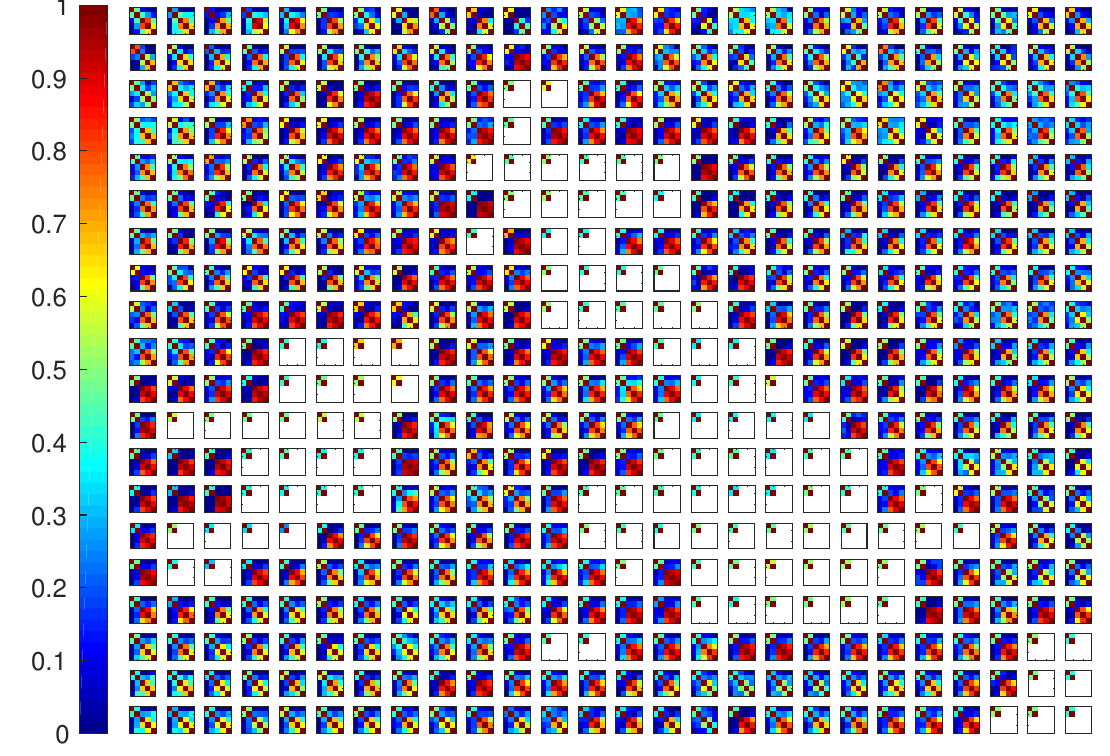
Figure 3. Estimated observation error correlation matrices for sub domains of the UKV.